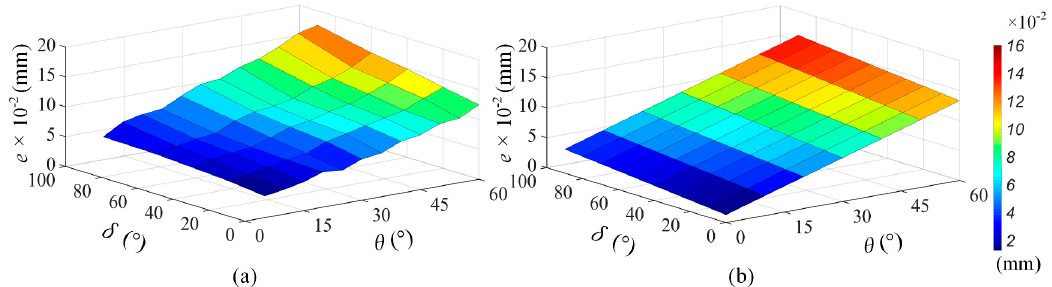
Figure 7. ( a ) Origin error map for the scan depth d = 79 mm; ( b ) the fitting form obtained from the empirical model in Equation